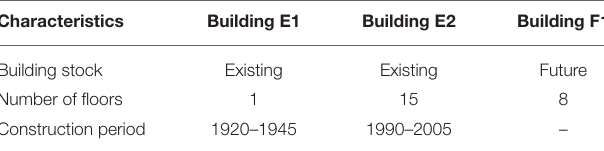
TABLE 5 | Sample buildings